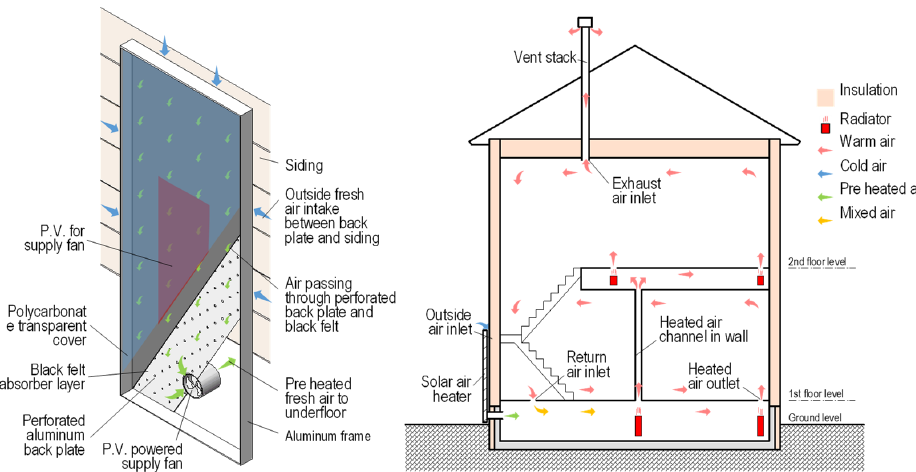
Figure 1. Outline of a passive ventilation system with a solar air heater. Table 1. Technical data specification of the wall-mounted a solar air